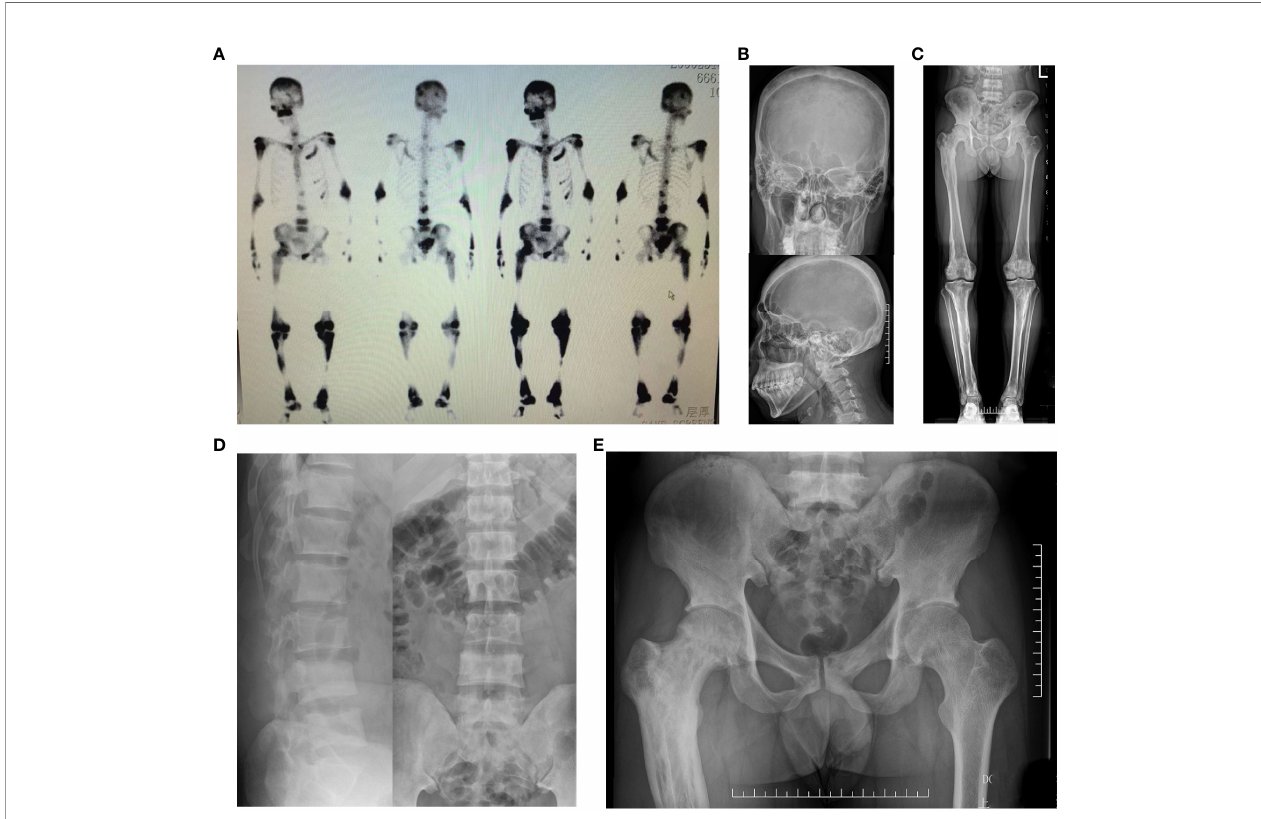
FIGURE 5 | Whole-body bone scintigraphy and radiographic fi ndings of the patient with HNRNPA2B1 mutation. (A) Whole-body bone scintigraphy of the patient showed radionuclide uptake in multiple bones. (B) The X-ray of skull showed the thickened skull plate barrier, and the slight enlarged skull bone with diffuse sclerotic foci. (C) The radiograph of the bilateral lower extremities revealed the heterogeneous density in both lower limbs with patchy areas of osteosclerotic, and irregular destruction of the cortical bone. (D) The lumbar spine radiographs showed the increased density in vertebral bodies with slight vertebral compression. (E) The pelvic radiograph showed the increased sclerosis sites in